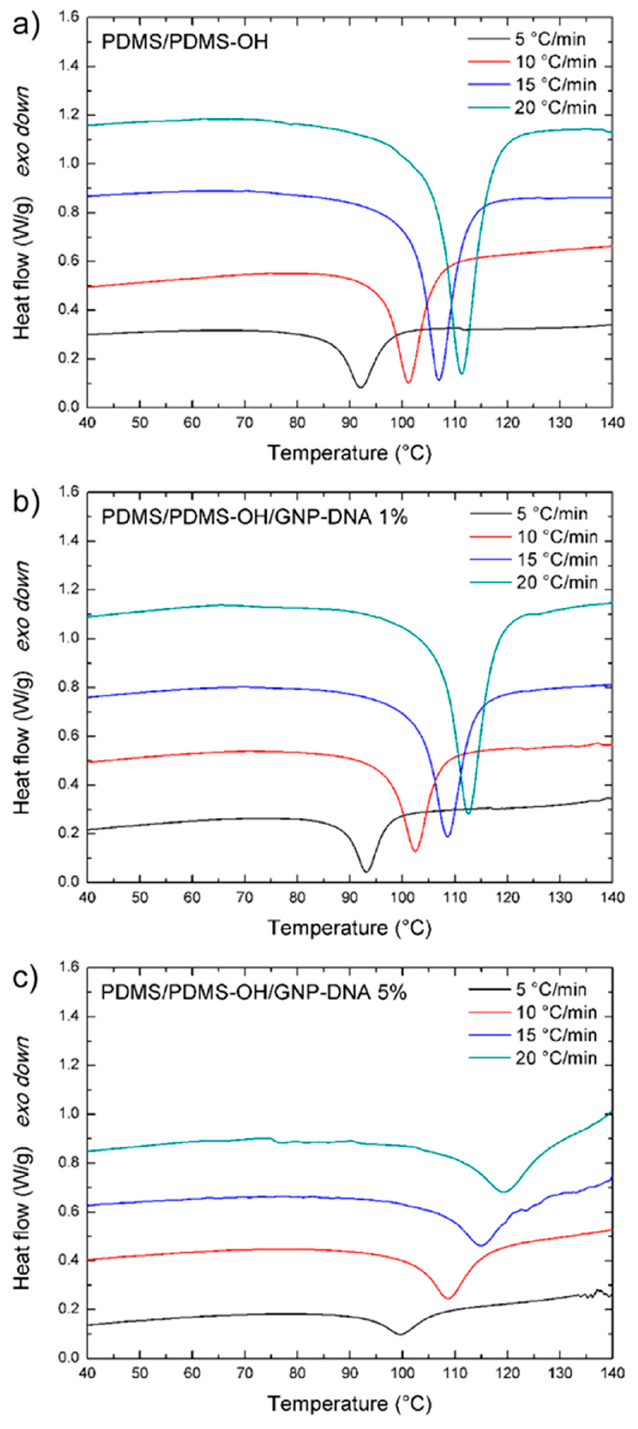
Figure 3. DSC thermograms of ( a ) PDMS / hydroxyl-terminated PDMS (PDMS–OH) (75:25 w / w), ( b ) PDMS / PDMS–OH / GNP–DNA 1 wt% and ( c ) PDMS / PDMS–OH / GNP–DNA 5 wt% nanocomposite mixtures at different heating rates.